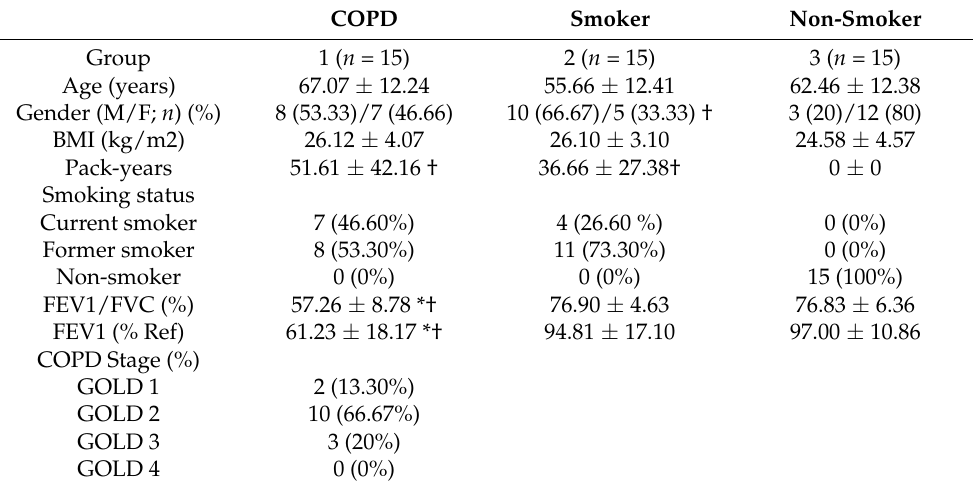
Table 1. Characteristics of the study